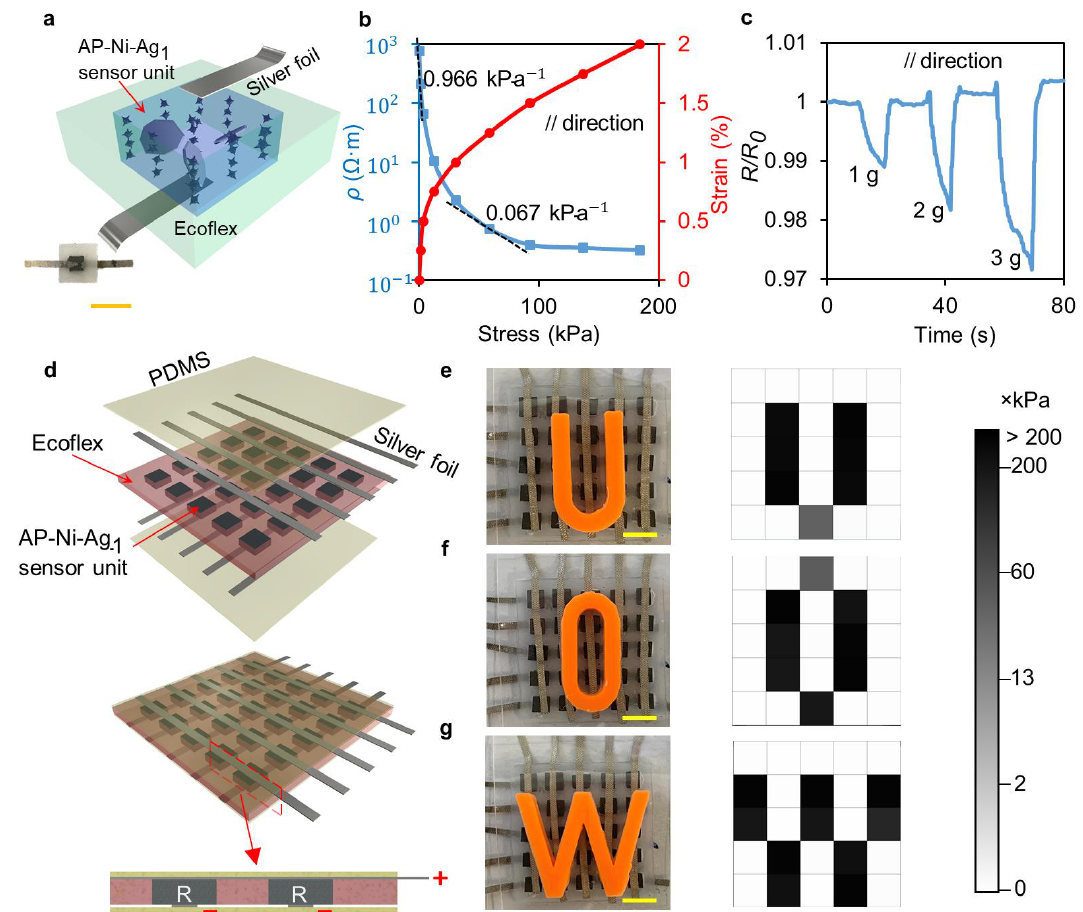
Figure 4. ( a ) Schematic diagram and real image of the AP-Ni-Ag 1 sensor unit. ( b ) The resistivity– stress curve of the sensor unit under 2% compression strain along the direction of magnetic field lines. ( c ) Relative resistance change of the sensor unit with the load of 1 g, 2 g, and 3 g. ( d ) Schematic diagram of E-skin with AP-Ni-Ag 1 -based 5 × 5 sensor array. Real images of the E-skin with human loading on ( e ) “U”, ( f ) “O”, and ( g ) “W” letter blocks and their corresponding grey-scale pressure pattern. The scale bars are 5 mm.